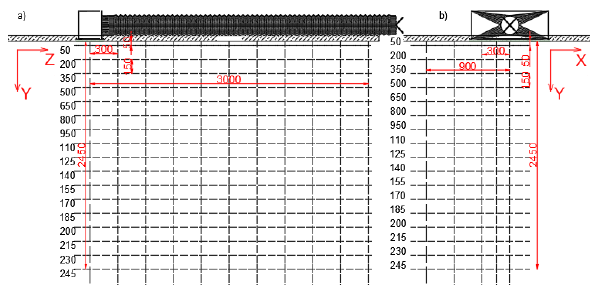
Fig. 2 . Measuring grid used (a) side view, (b) front view of the diffuser .